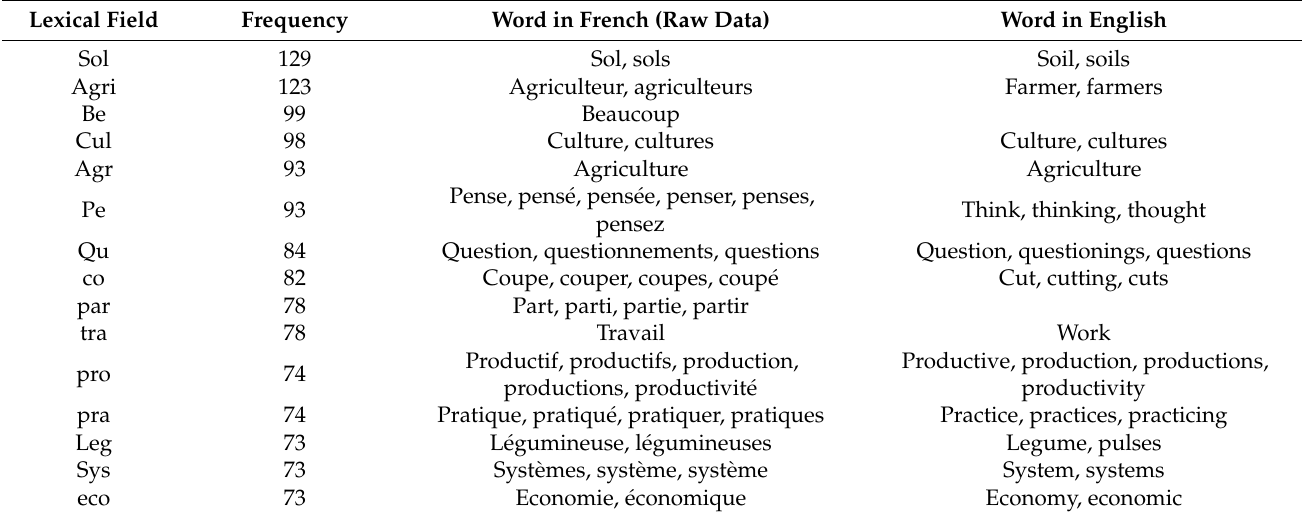
Table 2. Occurrences (frequency) per lexical field.